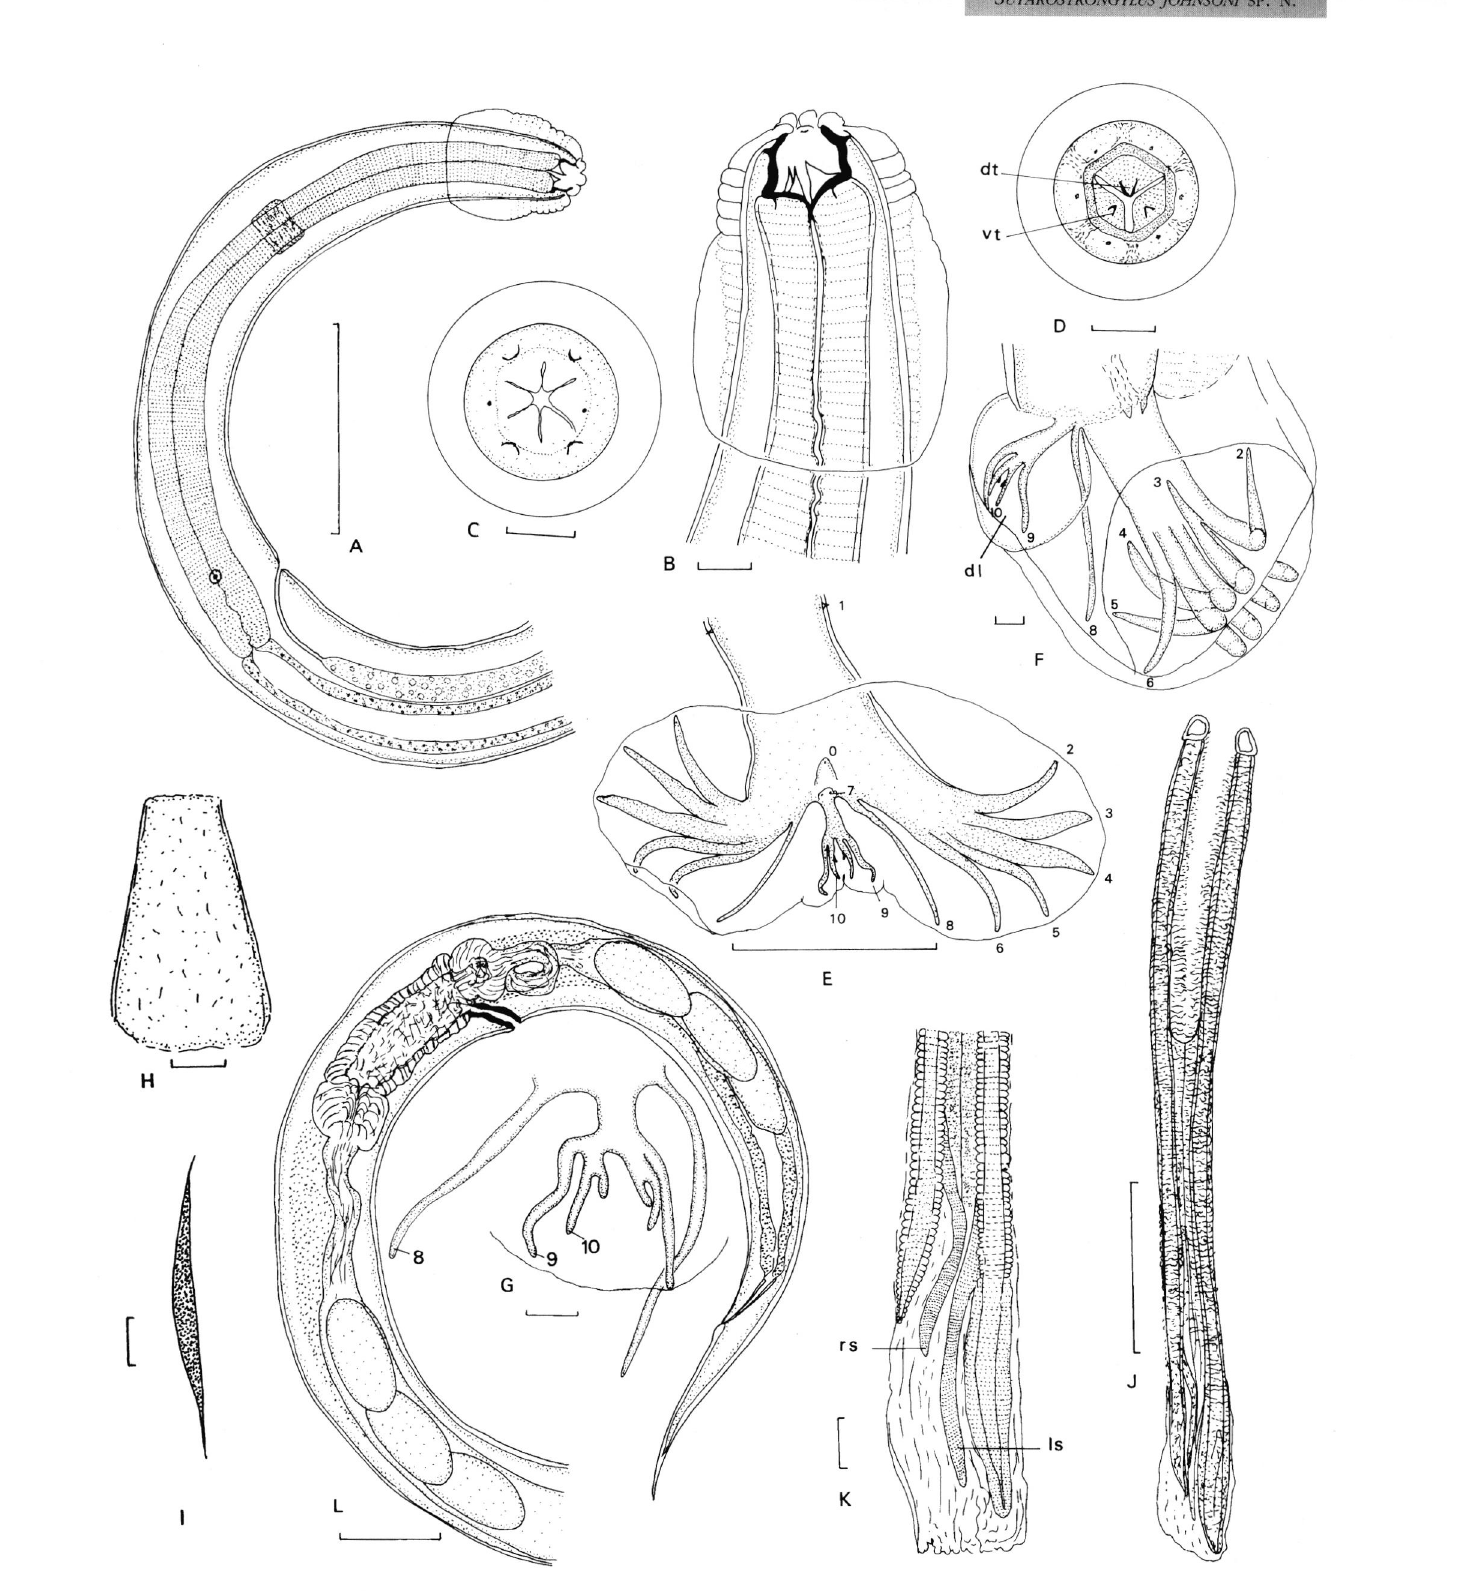
Fig. 1. - Sutarostrongylus johnsoni sp. n. from the pademelon, Thylogale stigmatica. A, anterior extremity, right, lateral view. B, cephalic- vesicle, left, lateral view. C, mouth opening, en face view, showing cephalic papillae and amphids. D, optical transverse section through buccal capsule showing single dorsal and two sub-ventral teeth. E, bursa, ventral view, with numbering of papillae and rays following system of Durette-Desset (1983). F. bursa, lateral view, showing swollen dorsal lobe (dl). G, dorsal ray. H, gubernaculum, ventral view. I. gubernaculum, lateral view. J, spicules, ventral view. K, spicule tips, ventral view. L, female tail, left lateral view. Abbreviations: dl: dorsal lobe of bursa; dt: dorsal tooth; Is: left spur of spicule; rs; right spur of spicule: vt: ventral tooth. Scale bars: A, F., J, L 100 μm ; B-D, F-I, K 10 μm